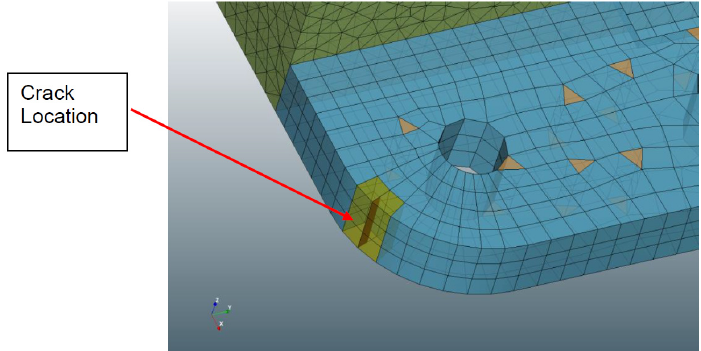
Figure 8. Through hole crack initiated on the wing root model.